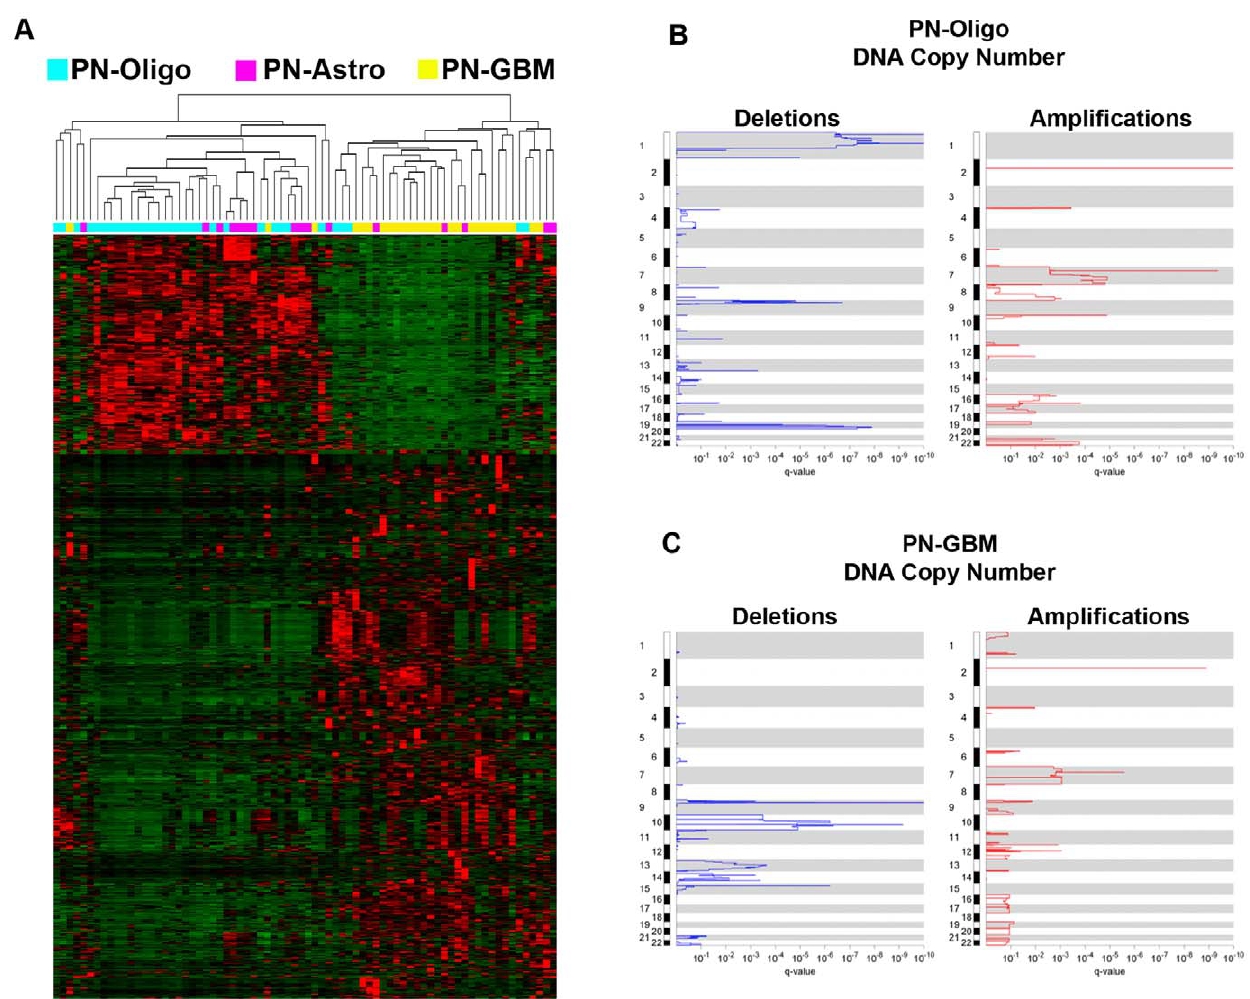
Figure 2. RNA and DNA copy number analysis of low- and high-grade proneural gliomas. ( A ) Supervised hierarchical clustering of Proneural GBM, Proneural Oligodendrogliomas, and Proneural Astrocytomas using 847 probes significantly different between these subtypes based on differential marker analysis (FDR , 5%, 1.8 Fold change). ( B ) Amplification and Deletion GISTIC Analysis of Proneural GBM and Proneural Oligodendrogliomas. Affymetrix SNP 6.0 data from the Rembrandt dataset was analyzed for copy number gain and loss using the GISTIC algorithm in GenePattern 3.0. A total of 26 Proneural GBM and 32 Proneural Oligodendroglioma samples were included in the analysis. No significant copy number changes were identified in the set of 14 Proneural Astrocytomas.